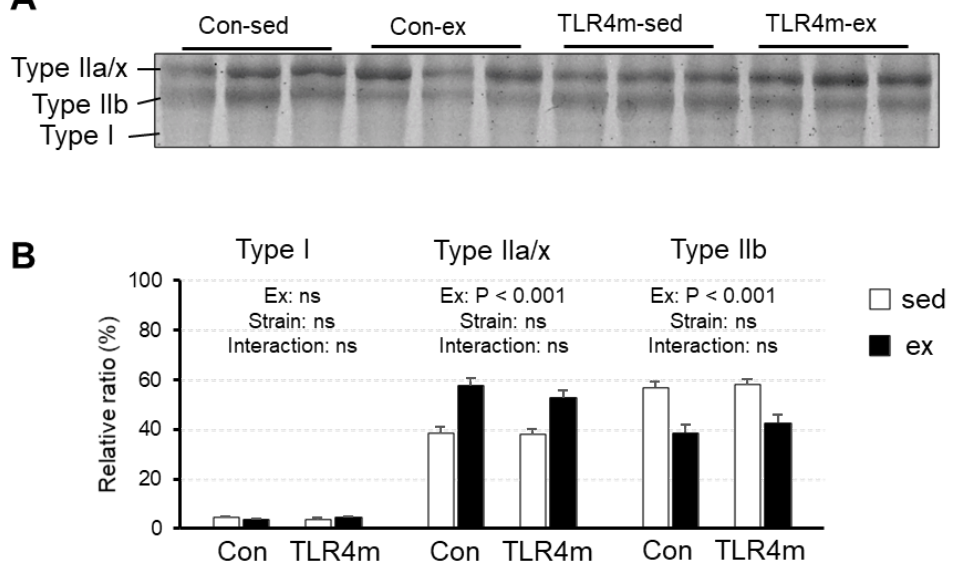
Figure 6. The relative expressions of myosin heavy chain (MHC) isoforms ( B ) in the plantaris. Representative images are shown ( A ). Values are means ± standard error; n = 6 per group. Differences between the groups were considered to be significant if p < 0.05.